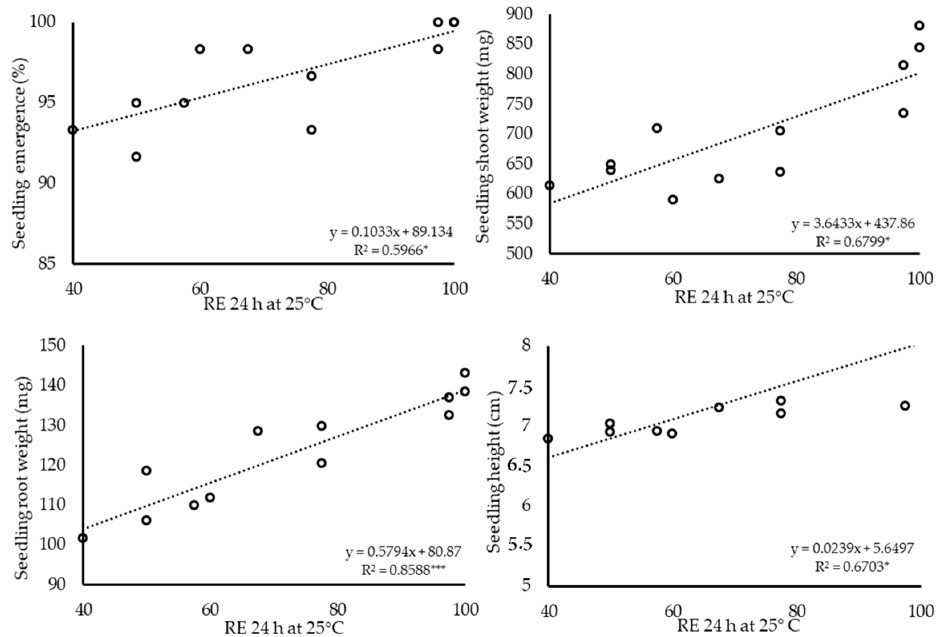
Figure 4. The relationship between radicle emergence percentages after 24 h (RE 24 h) after germination test were set up at 25 ◦ C and seedling emergence (%), seedling shoot weight (mg), seedling root weight (mg) and seedling height (cm) of 12 hybrid cucumber seed lots in low temperature stress. Seedling parameters were calculated after 14 days, in which seedling trays were kept at 15 ◦ C for 3 days and 22 ◦ C subsequently. Values were derived from Table 2. * p < 0.05, *** p <